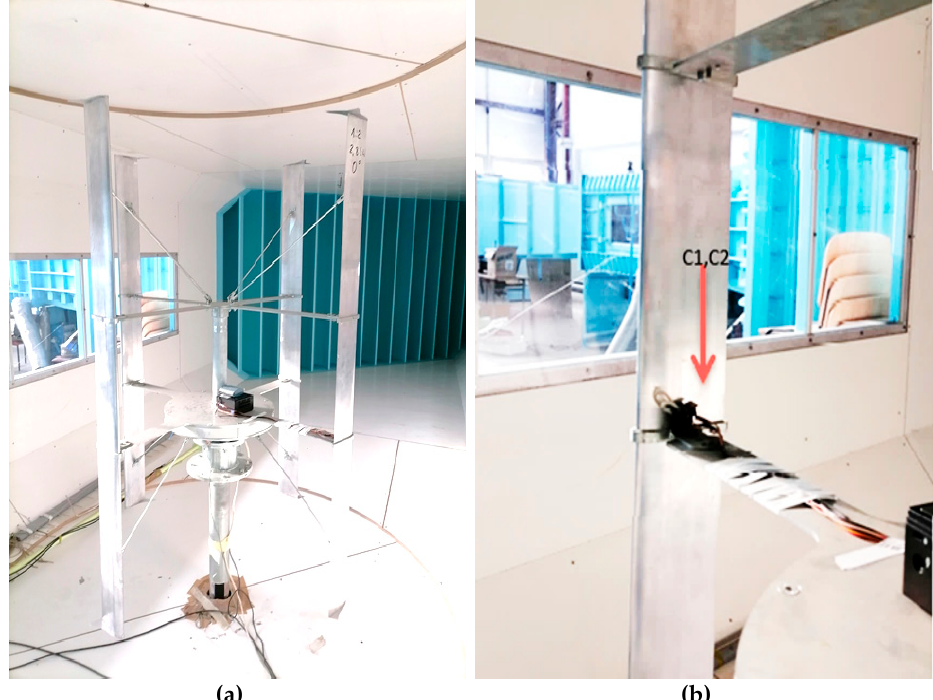
Figure 8. Photos of the study of the impact of acceleration on a V-type wind turbine, ( a ) view of the entire turbine experimental stand, and ( b ) magnified view on the sensor installed on the turbine